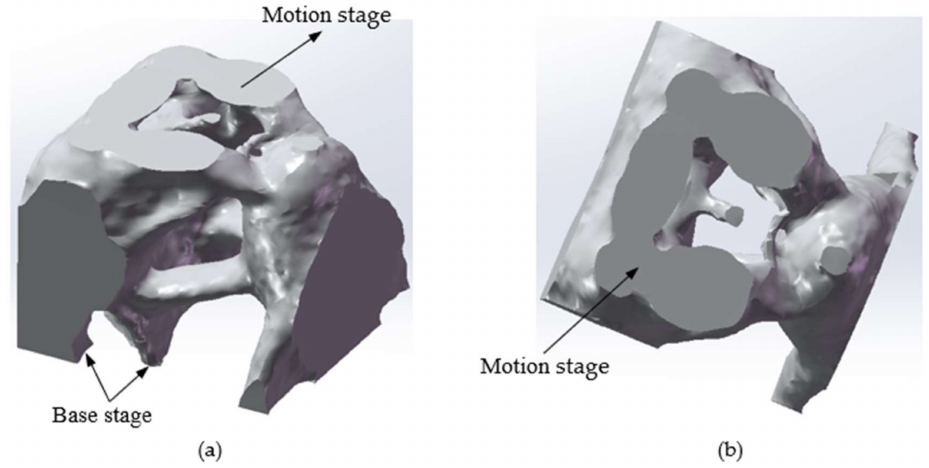
Figure 3. Topology optimization structure of the three-DOF spatially compliant mechanism,